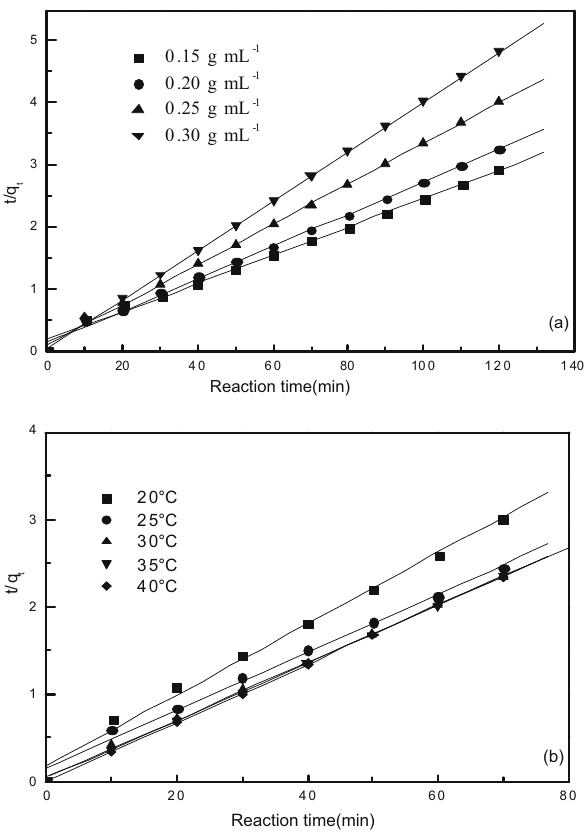
Figure 5: Pseudo - second - order plots of GPC adsorption on resin 001 × 7 at di ff erent ( a ) adsorbent dosages and ( b ) temperatures.